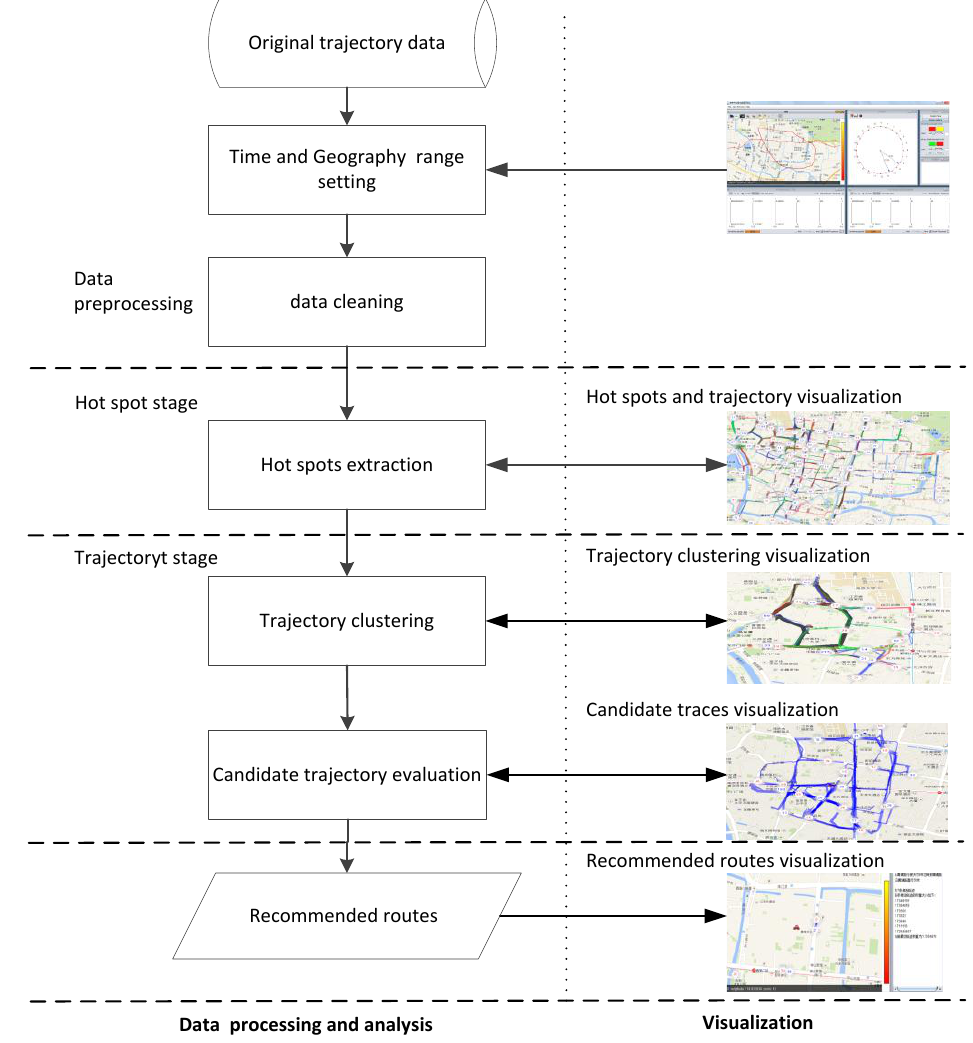
Figure 1. The workflow